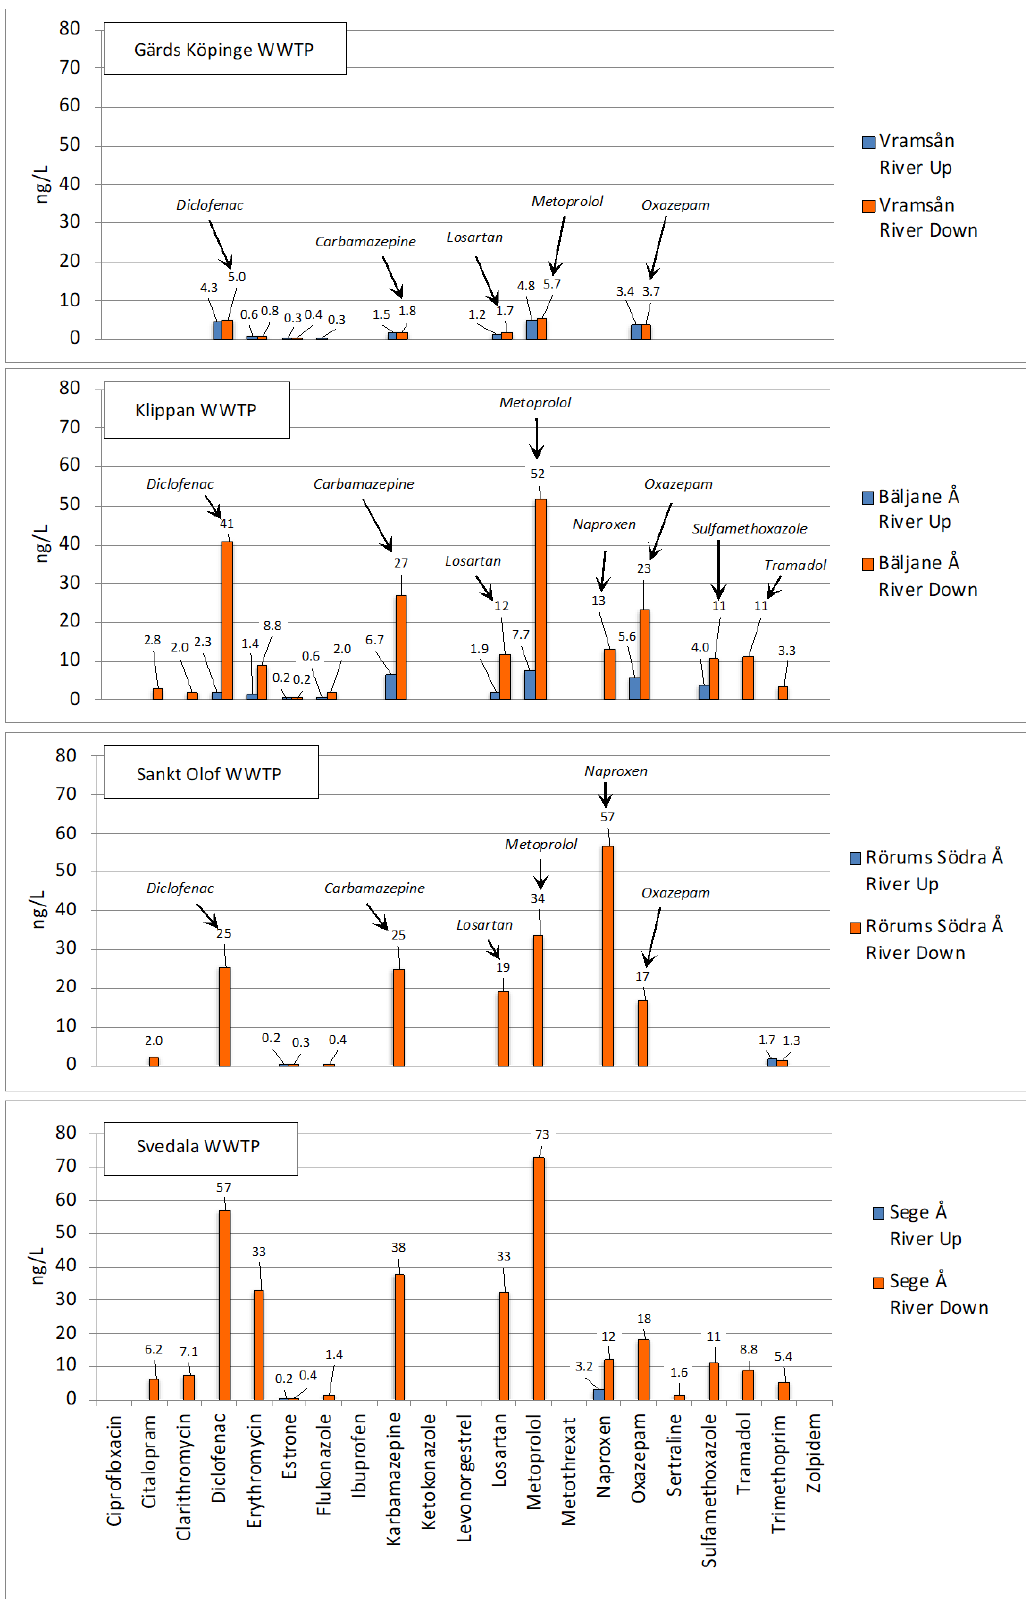
Figure 9. Measured concentrations of pharmaceuticals in the 4 investigated rivers, upstream (Up) and downstream (Down) of the WWTPs.